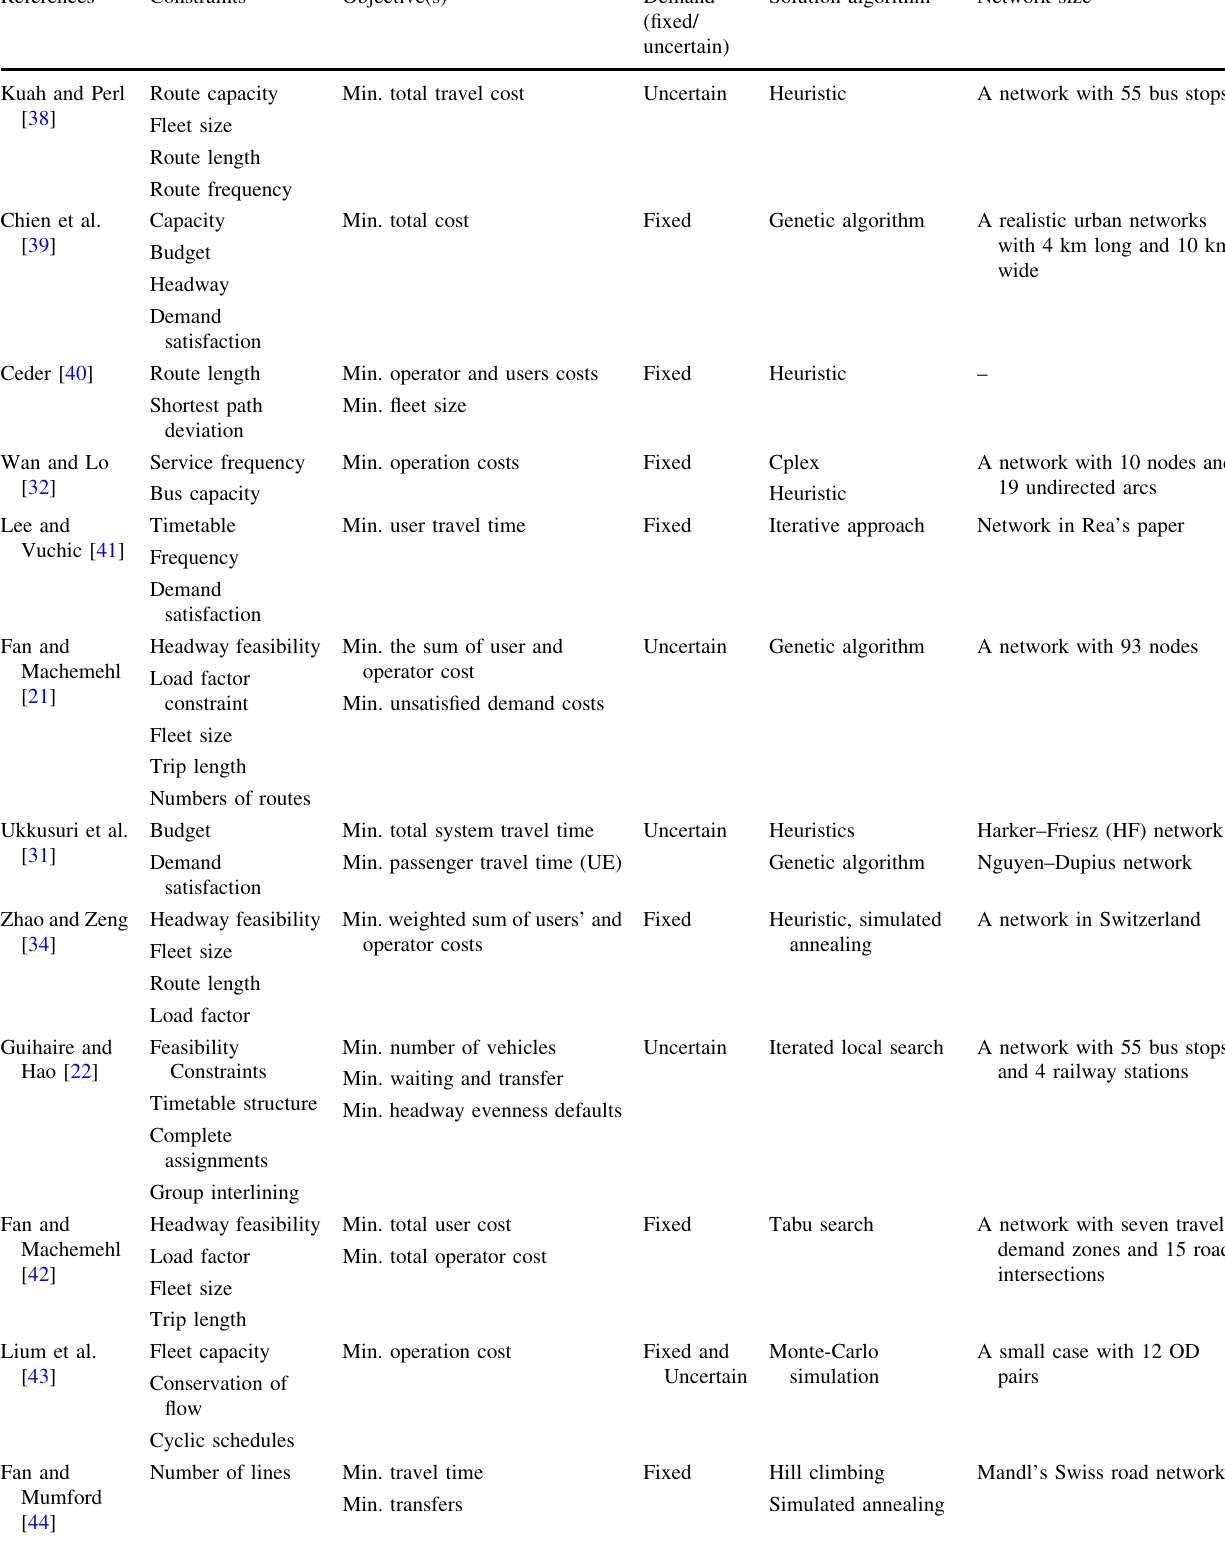
Table 1 A summary of urban transit network design